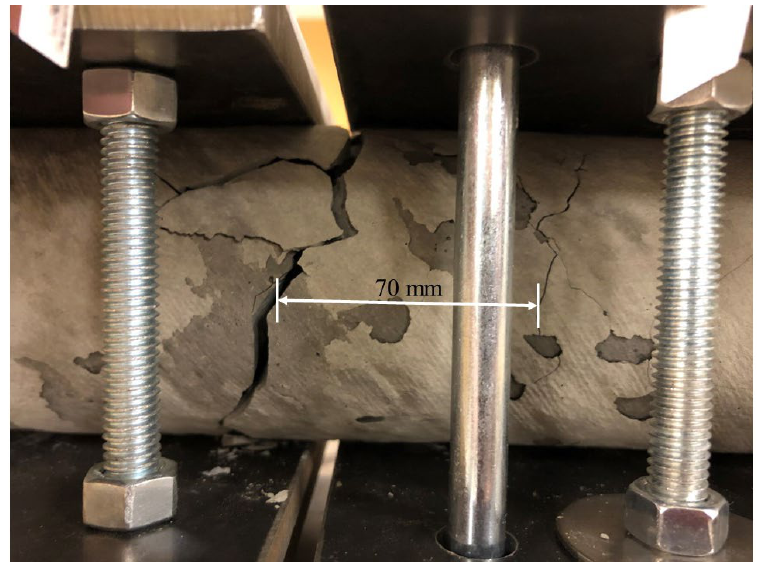
Figure 14. Cracked cement beam after a shear deformation test in which a kink length of 70mm was developed.